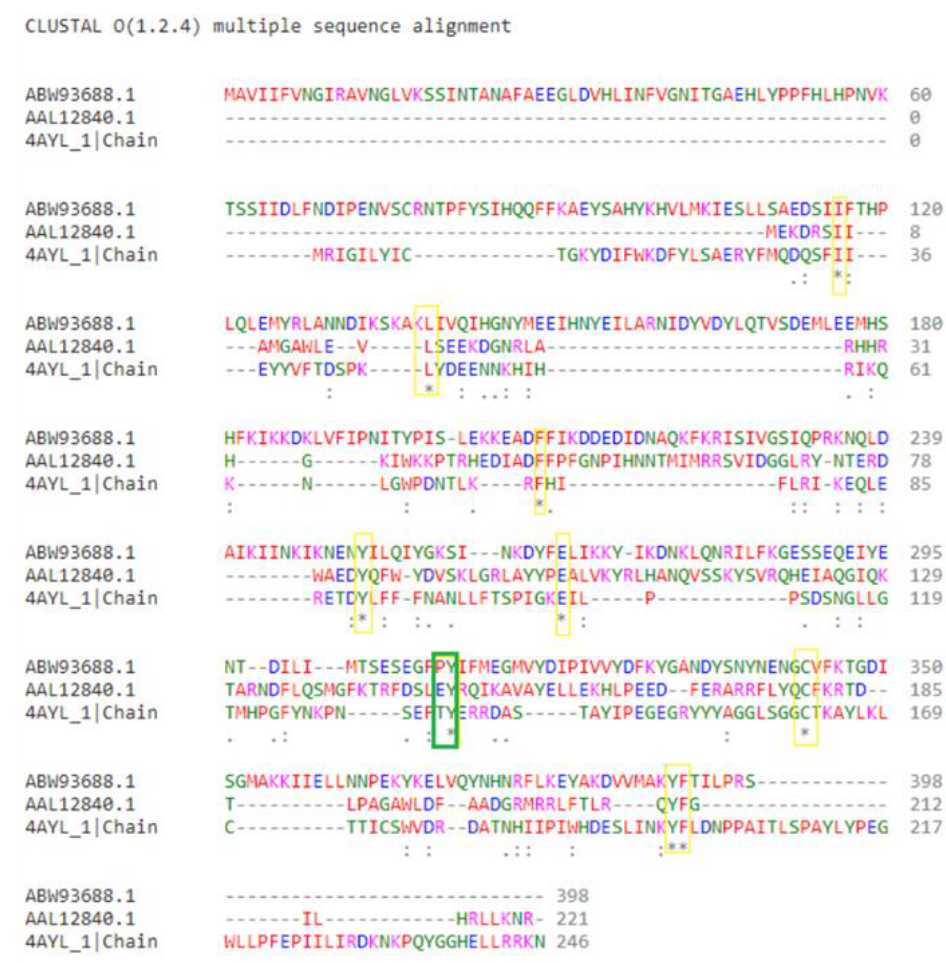
Figure 1. ClustalO multiple sequence alignment of NmW-GT domain (ABW93688.1) aligned with LgtA (AAL12840.1) and BoGT56a (4AYL_1). An asterisk “*” indicates conserved amino acids at that position in all three sequences. A colon “:” represents strong similarity in chemical properties at that amino acid position. A period “.” represents weaker similarity at a particular amino acid position. Identical residues among all three sequences are highlighted by a yellow box. The position of NmW Pro310 is highlighted in green with aligned residues in LgtA and BoGT56a. Reprinted with permission from [63]. Copyright 2021 Subhadra